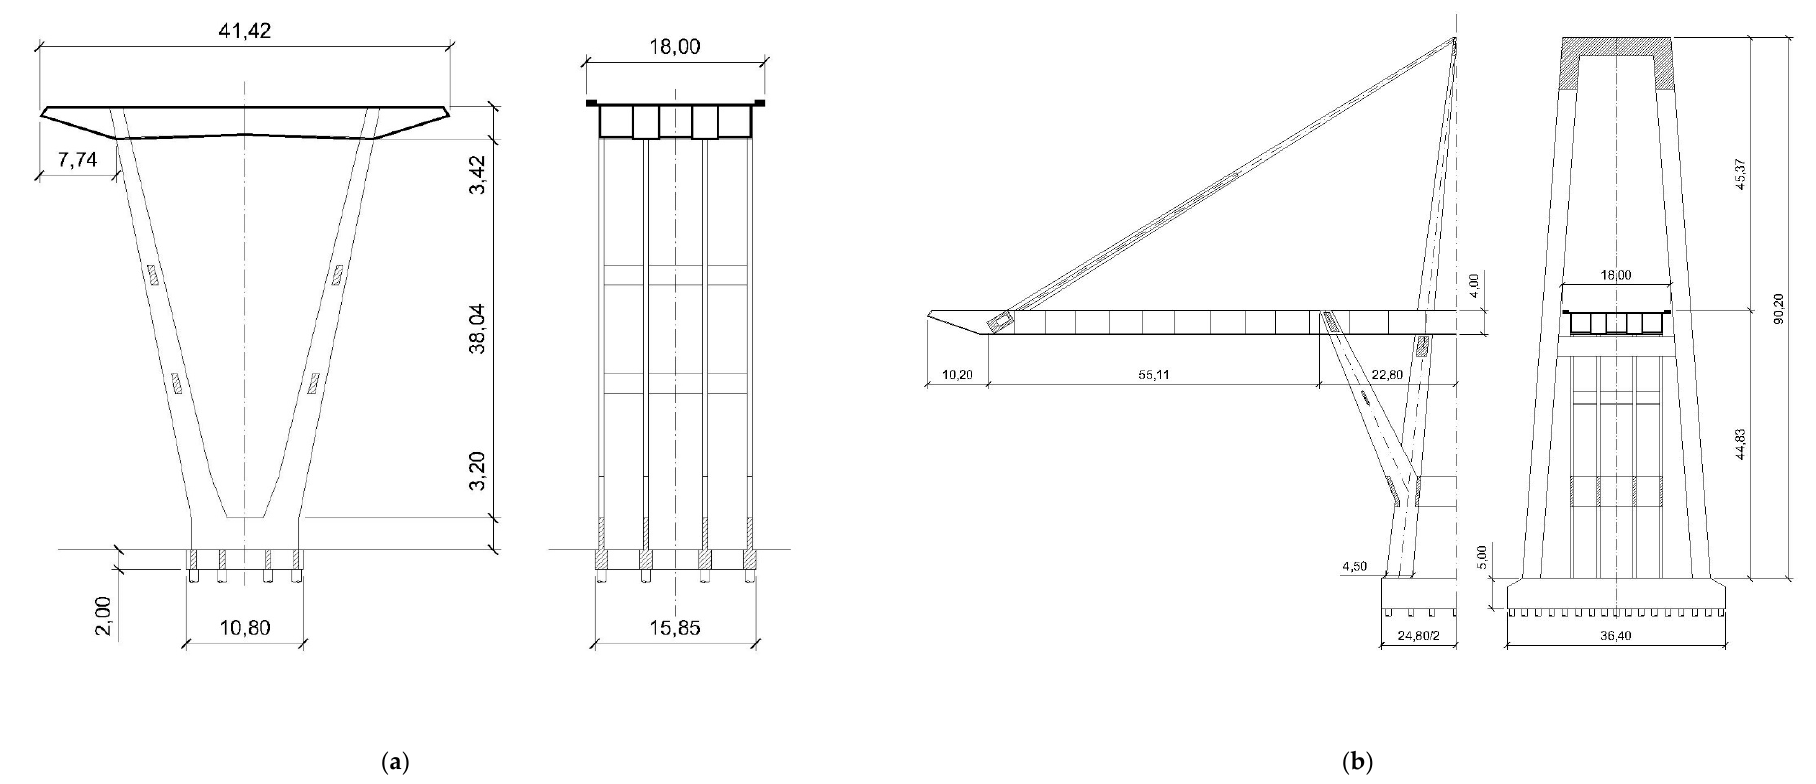
Figure 3. ( a ) Overpass support (longitudinal and cross-section) (Morandi, 1968). ( b ) Viaduct support (longitudinal and cross section) (Morandi, 1968).